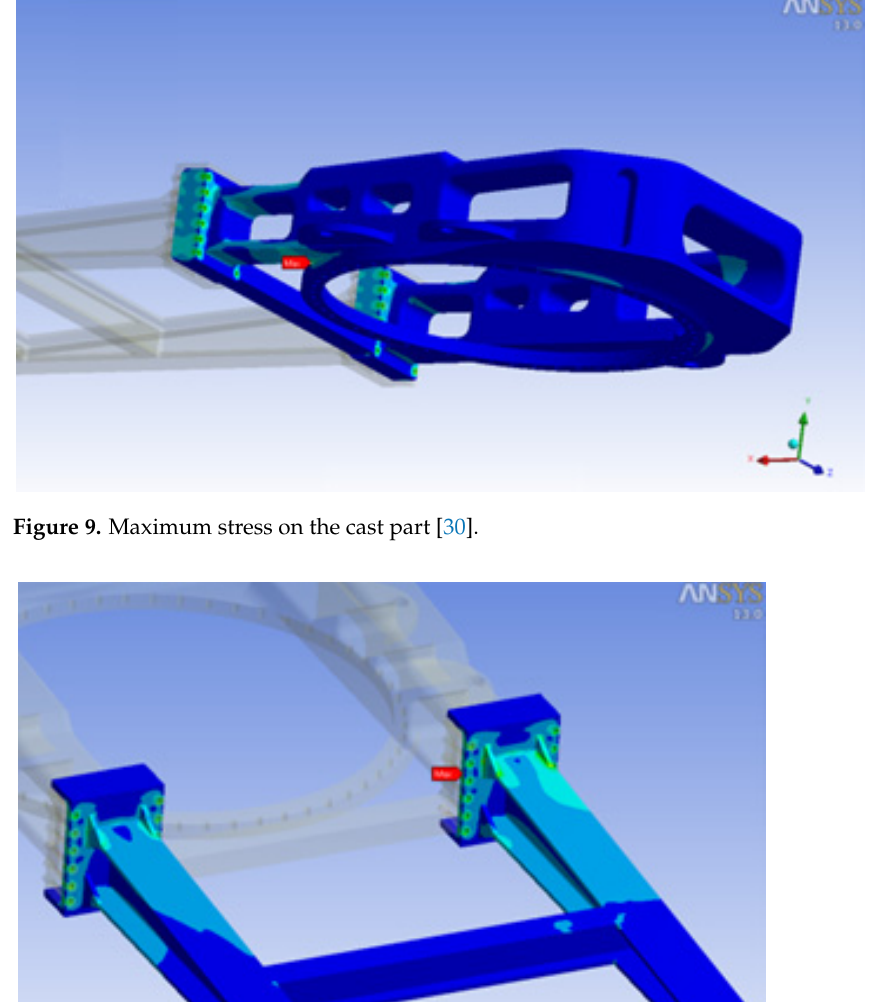
Figure 8. Reaction force calculations [30].